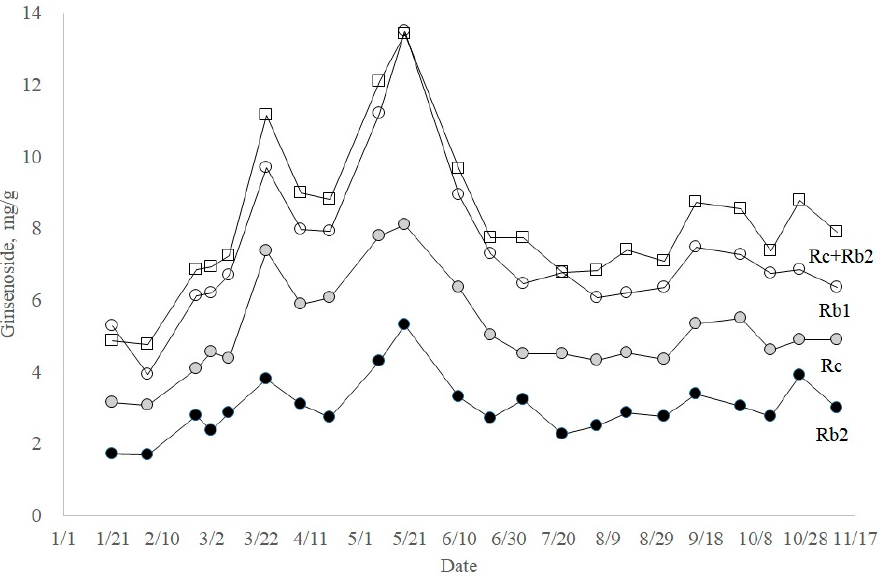
Figure 8. Seasonal changes of PPD ginsenosides Rc and Rb2 (open square), Rb1 (open circle), Rc (shaded circle), and Rb2 (closed circle).